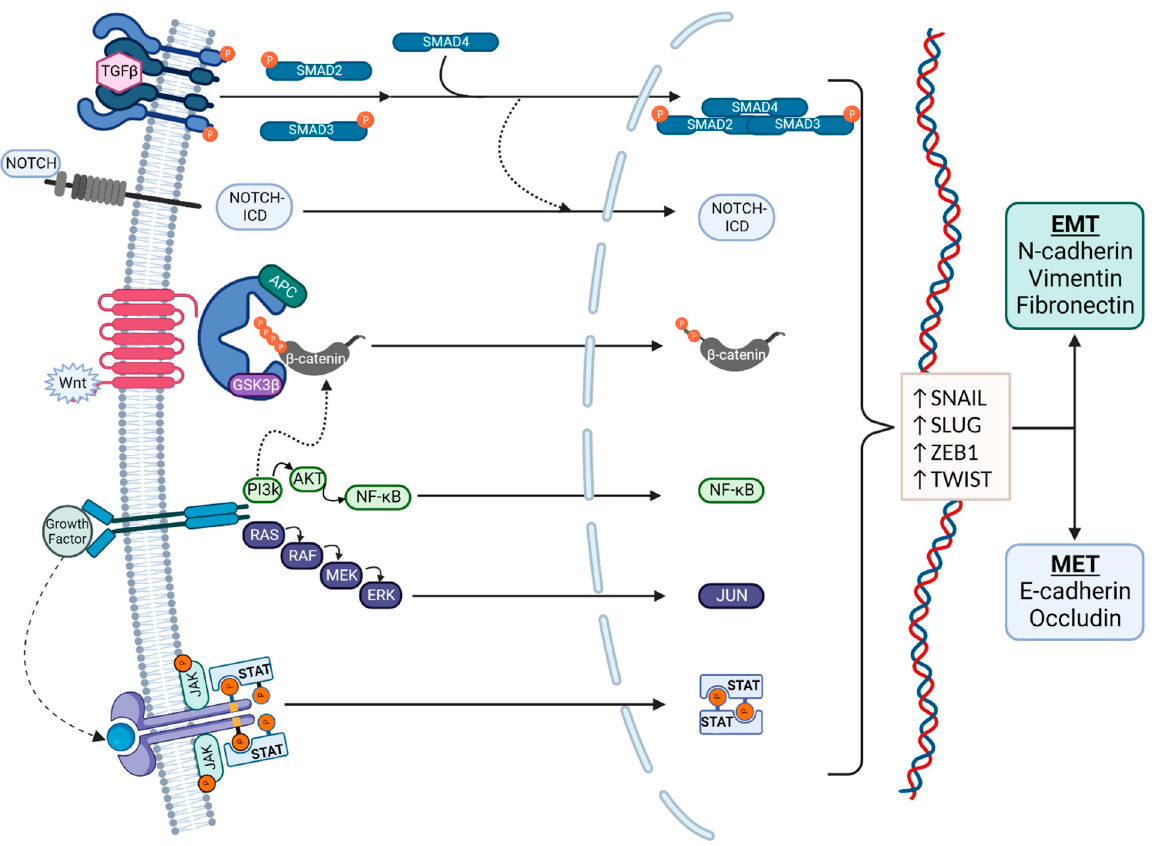
Figure 2. Signaling pathways in EMT. EMT regulation is complex and affected by multiple path- ways, which also interact with each other. Regulation is typically via the Transforming Growth Fac- tor β (TGF β )/SMAD, Notch, canonical wnt , phosphoinositide 3-kinase (PI3K)/Akt, RAS/RAF, and JAK/STAT pathways. The transcription factors that mediate EMT are primarily Snail, Slug, ZEB1, and TWIST. EMT is characterized by an increased production of N-cadherin, vimentin, and fibronectin, and MET is characterized by an increased production of E-cadherin and Occludin.